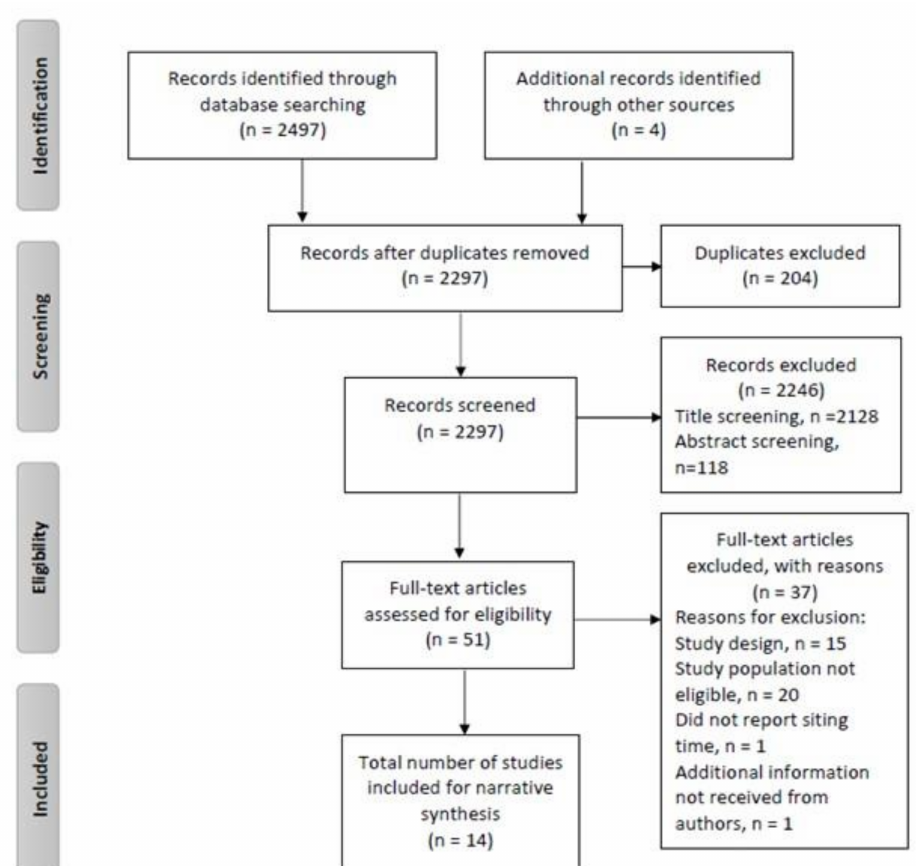
Figure 1. PRISMA flow chart of the study selection